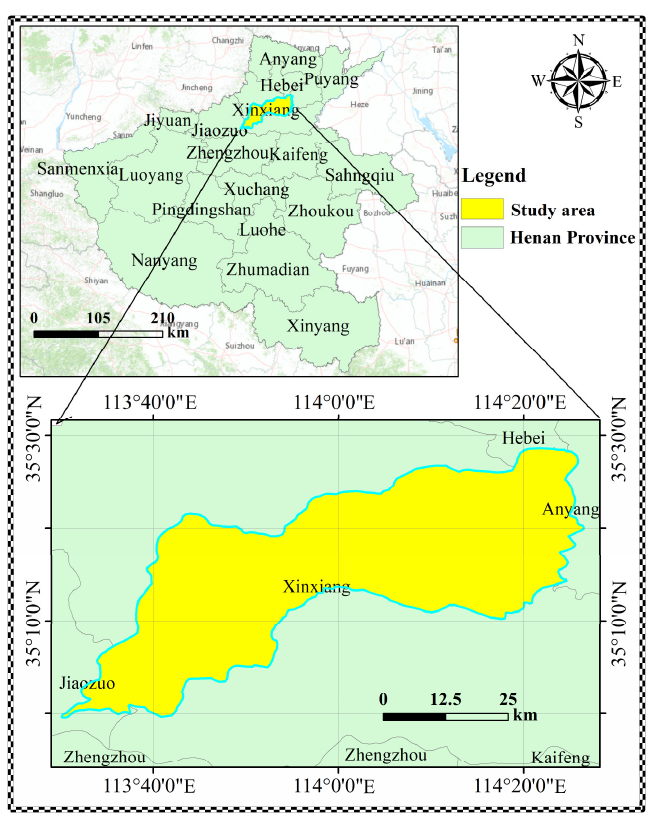
Figure 4. Location map of the study area.